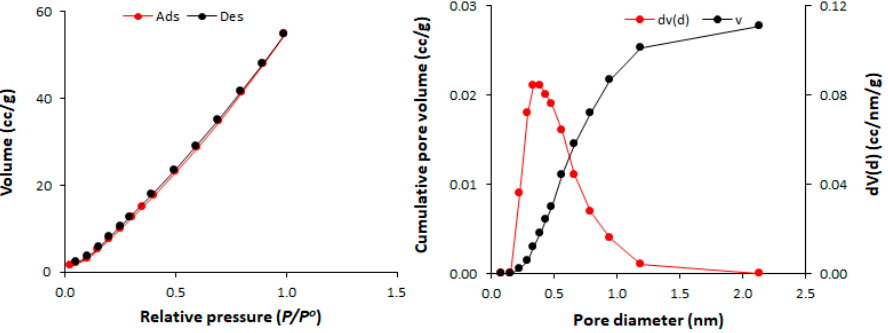
Figure 5. N 2 isotherms and pore size for 1 .